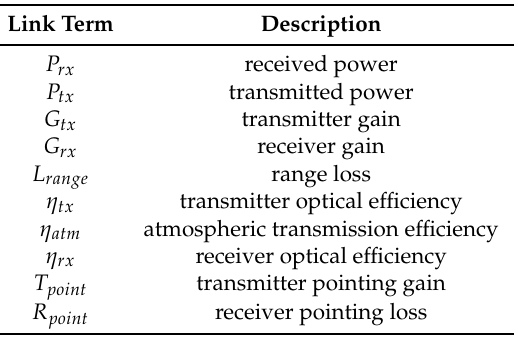
Table A2. The link terms are used to describe the communication link and are combined to determine how much of the transmitted power is captured by the receiver.